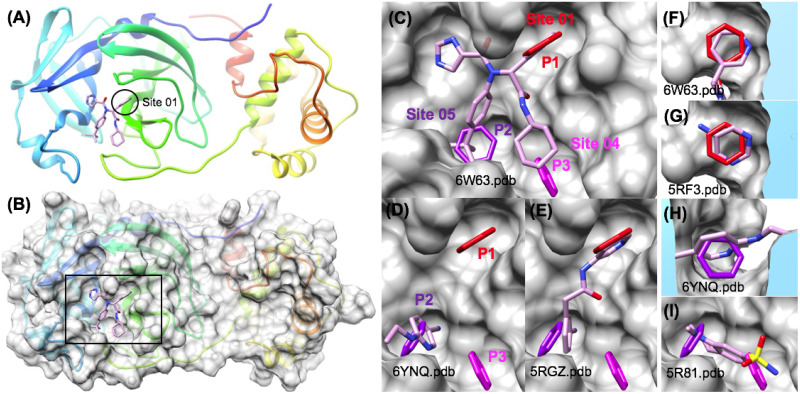
Pharmacophore mapping successfully identifies Nsp5 Mpro inhibitor substrate recognition site pharmacophores.The crystal structure of Nsp5 Mpro (6W63.pdb) bound to a broad spectrum non-covalent inhibitor is shown using ribbon diagram with rainbow coloring (A) and is shown with a transparent gray surface in (B). The three protease P1, P2, and P3 substrate recognition binding pockets were identified with favorable aromatic pharmacophores as shown for Site 01, Site 05 and Site 04 respectively (C). Several crystal structures of other fragment ligands (6YNQ.pdb, 5RGZ.pdb, 5RF3.pdb, 6YNQ.pdb, 5R81.pdb) independently confirm the position of the Site 01 (P1) and Site 05 (P2) pharmacophores shown in (D) thru (I).